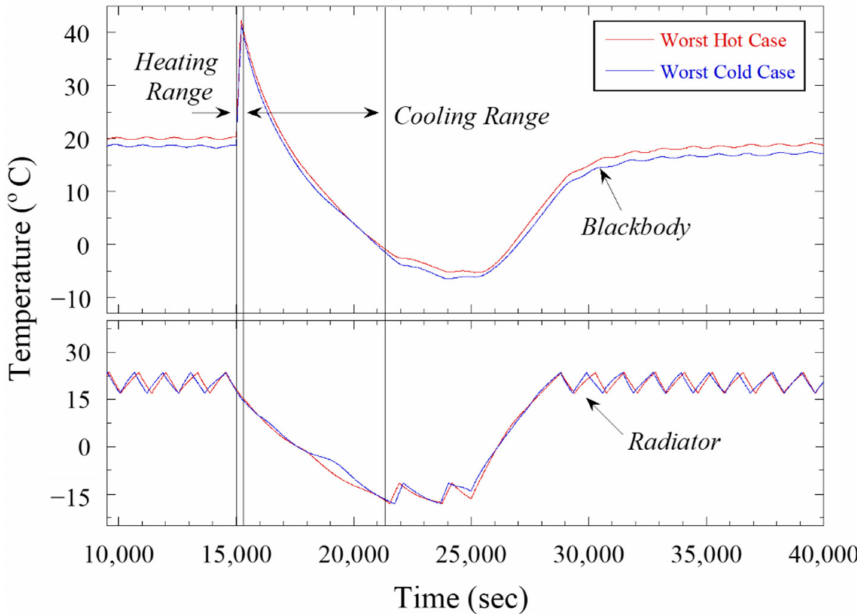
Figure 6. Temperature profile on BB surface and radiator in normal heat pipe operation